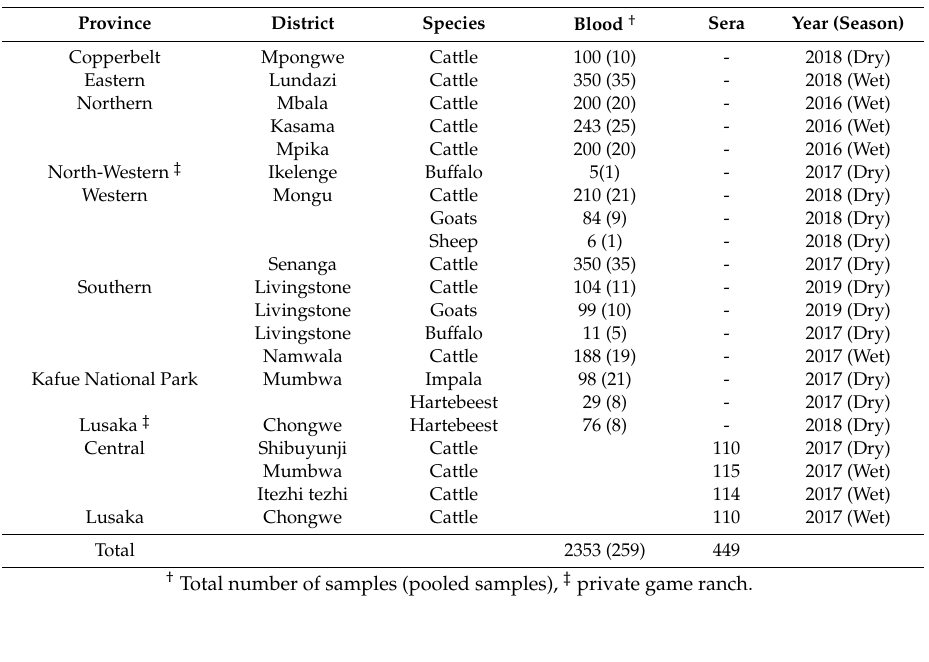
Table 1. Summary of blood and serum samples collected from domestic and wild ruminants in selected provinces Zambia.